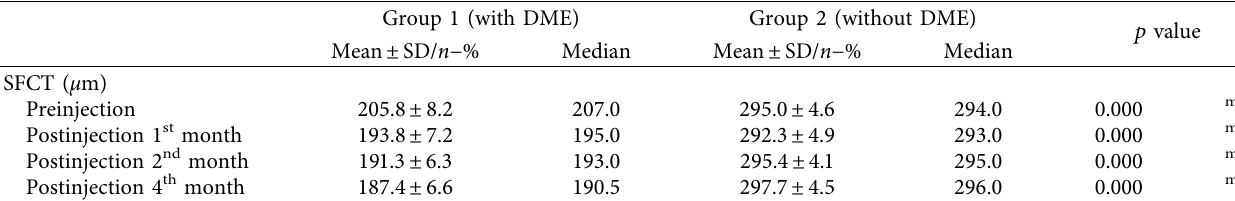
Table 3: Change in subfoveal choroidal thickness of the